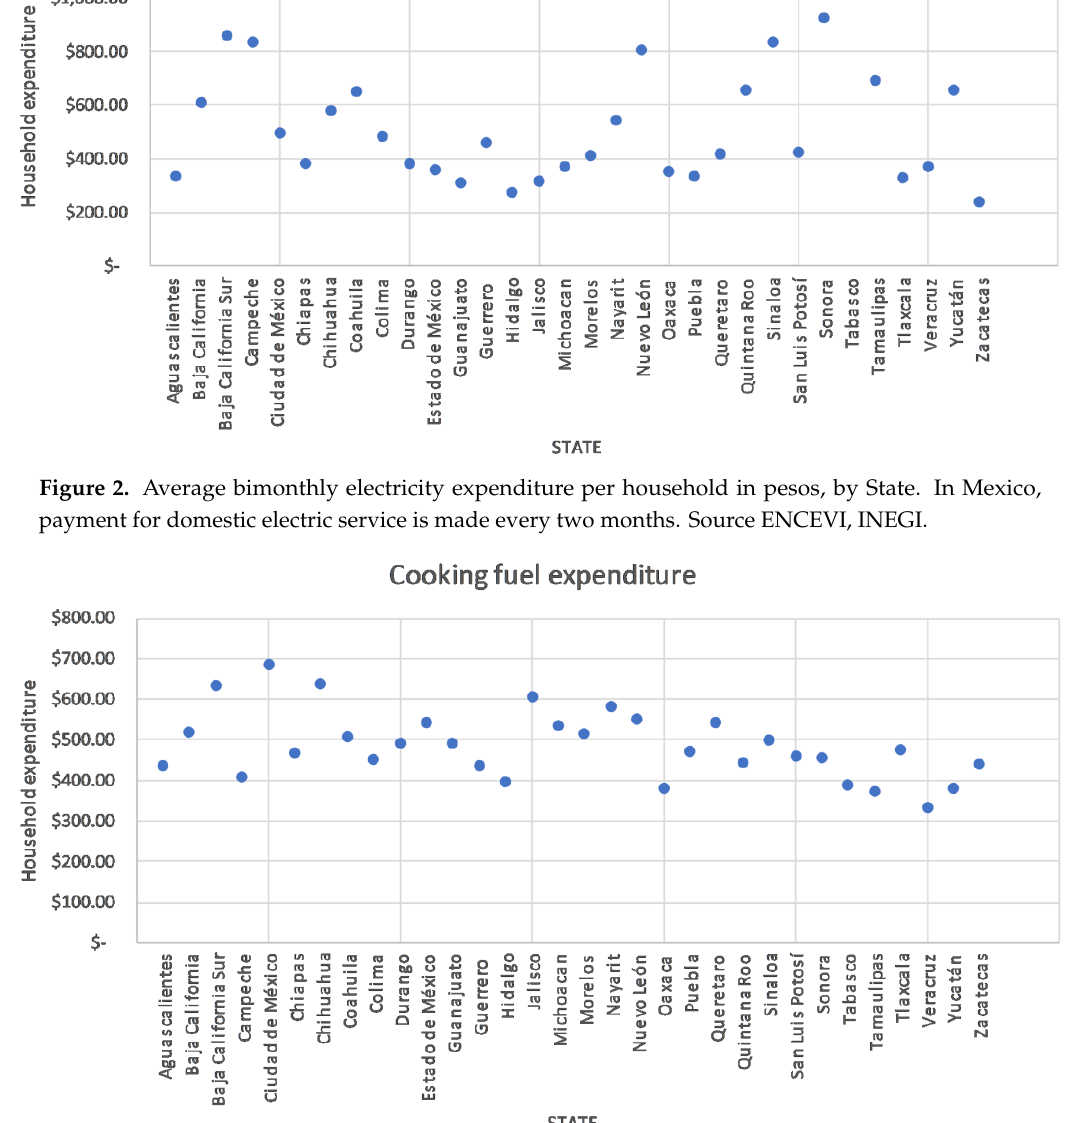
Figure 3. Average monthly cooking fuel expenditure per household in pesos, by State. Source ENCEVI, INEGI.